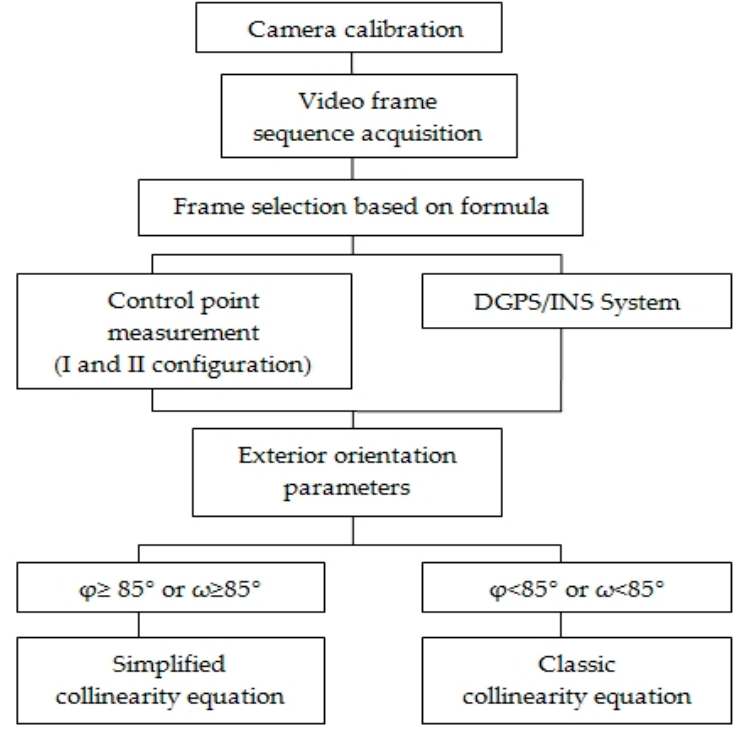
Figure 13. Proposed methodology for integrating video images acquired from terrestrial and aerial orientations of the camera mounted on the UAV.